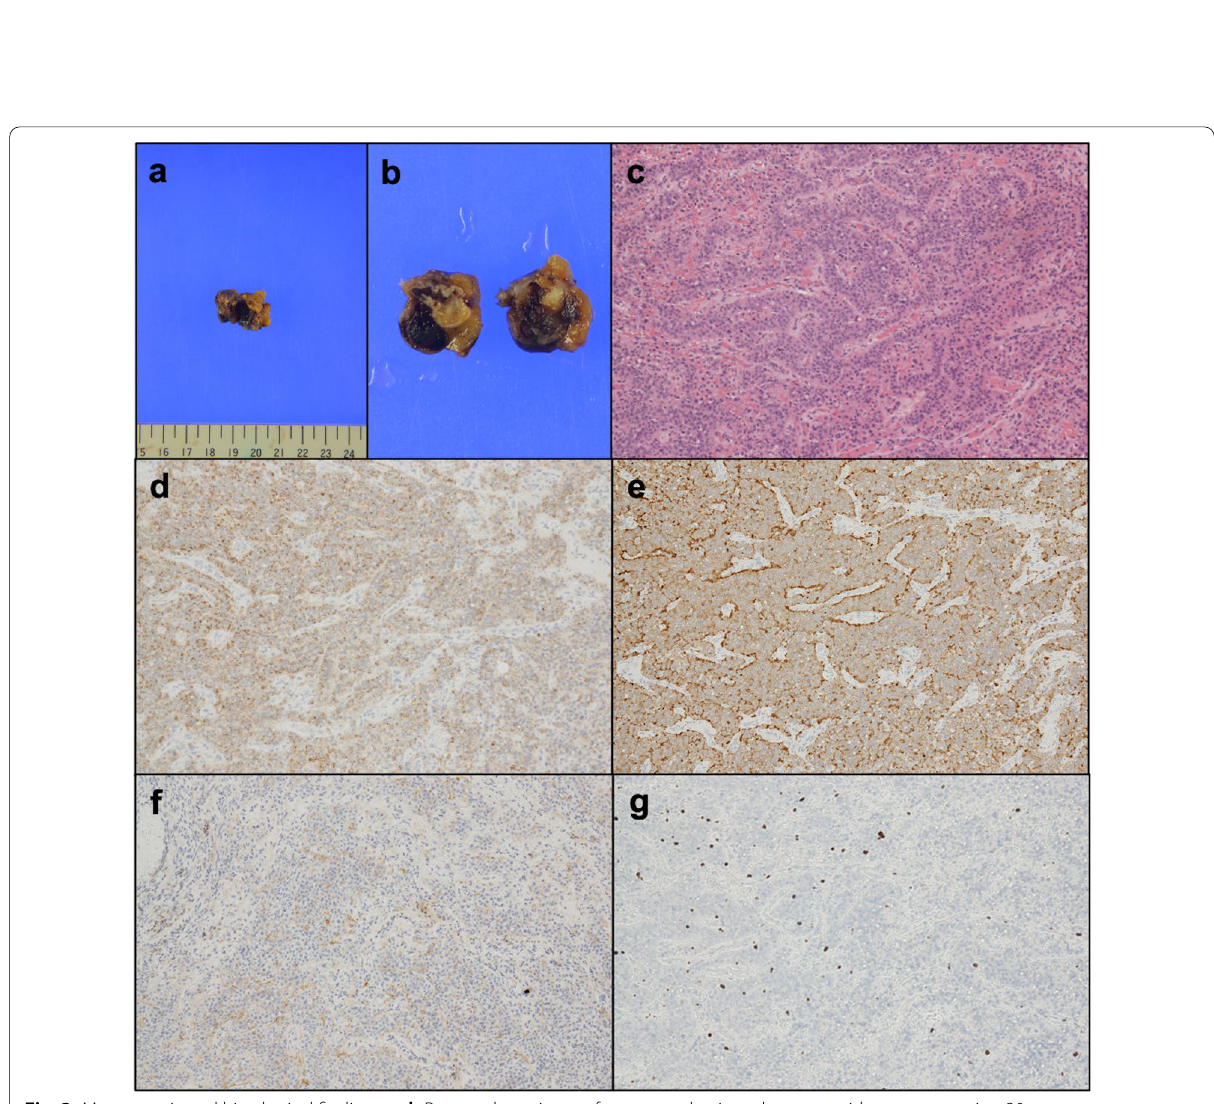
Fig. 3 Macroscopic and histological findings. a , b Resected specimen of omentum having a brown ovoid mass, measuring 20 mm. c – g Microscopic findings. Trabecular or ribbon growth of cuboidal cells with microvessels ( c HE stain, 10). Tumor cells were positive for chromogranin × A ( d 10), synaptophysin ( e 10), CD56 ( f 10). Ki-67 index was 5% ( g × × × ×